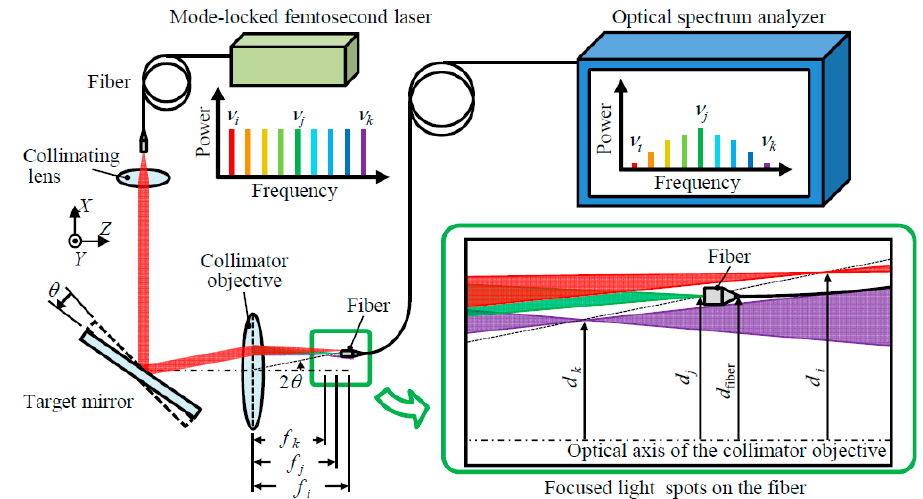
Figure 11. Optical setup for measurement of the small angular displacement of an object based on the chromatic aberrations of a simple lens [58].